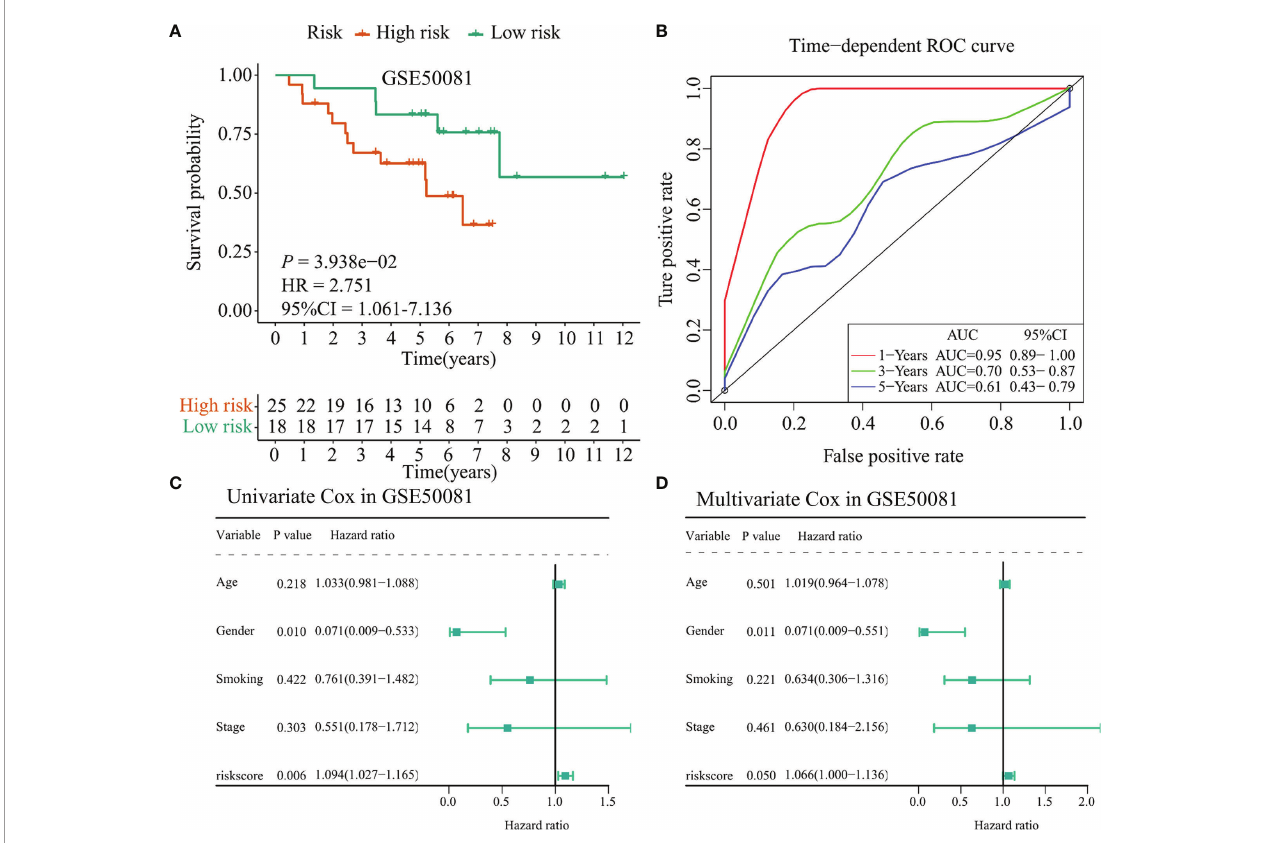
FIGURE 8 | Validation of the TCGA-LUSC signature in the GSE50081 dataset. (A) Kaplan – Meier curve presented the survival difference between high-risk group and low-risk group. (B) Time-dependent ROC curves at 1 year, 3 years, and 5 years. (C) Univariate Cox regression analysis regarding the risk score and other clinical parameters. (D) Multivariate Cox regression analysis about the risk score and else clinical parameters. TCGA: The Cancer Genome Atlas; LUSC: lung squamous cell